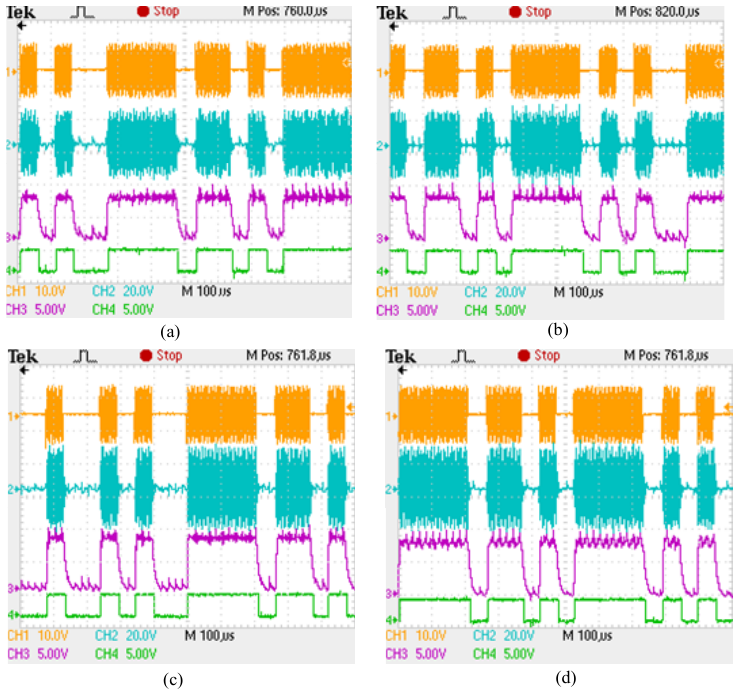
Figure 8. ( a ) The forward data transfer results when power transfer is off; ( b ) the forward data transfer results when power transfer is on; ( c ) the backward data transfer results when power transfer is off; ( d ) the backward data transfer results when power transfer is on.